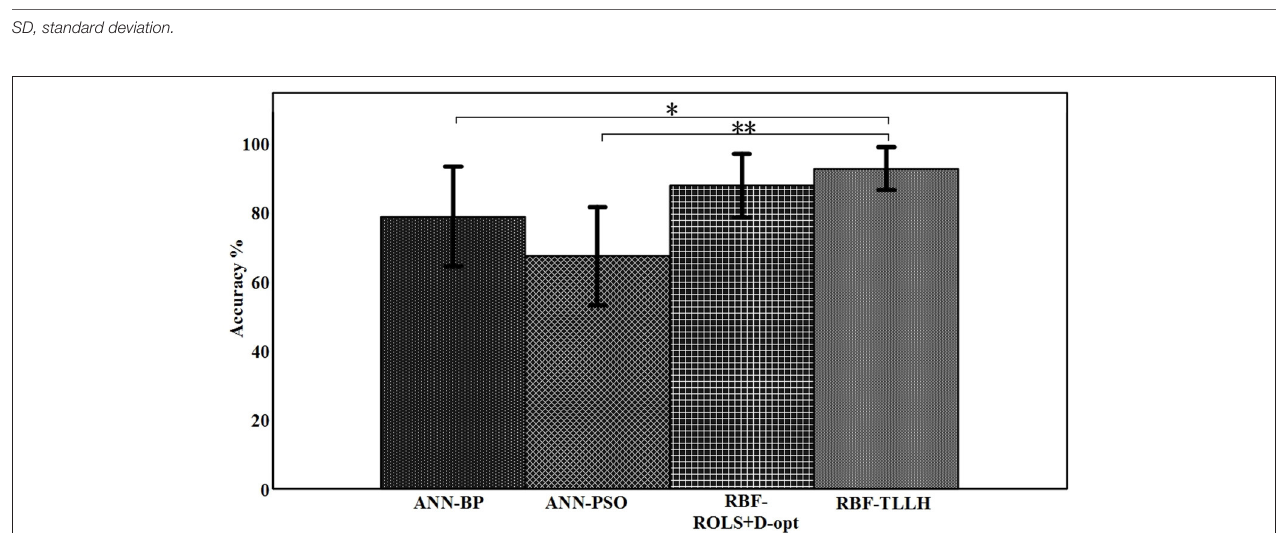
FIGURE 6 | Bar chart of the mean accuracies when using different classifiers. *significantly different from control ( p < 0.05); **significantly different from control ( p < 0.005).